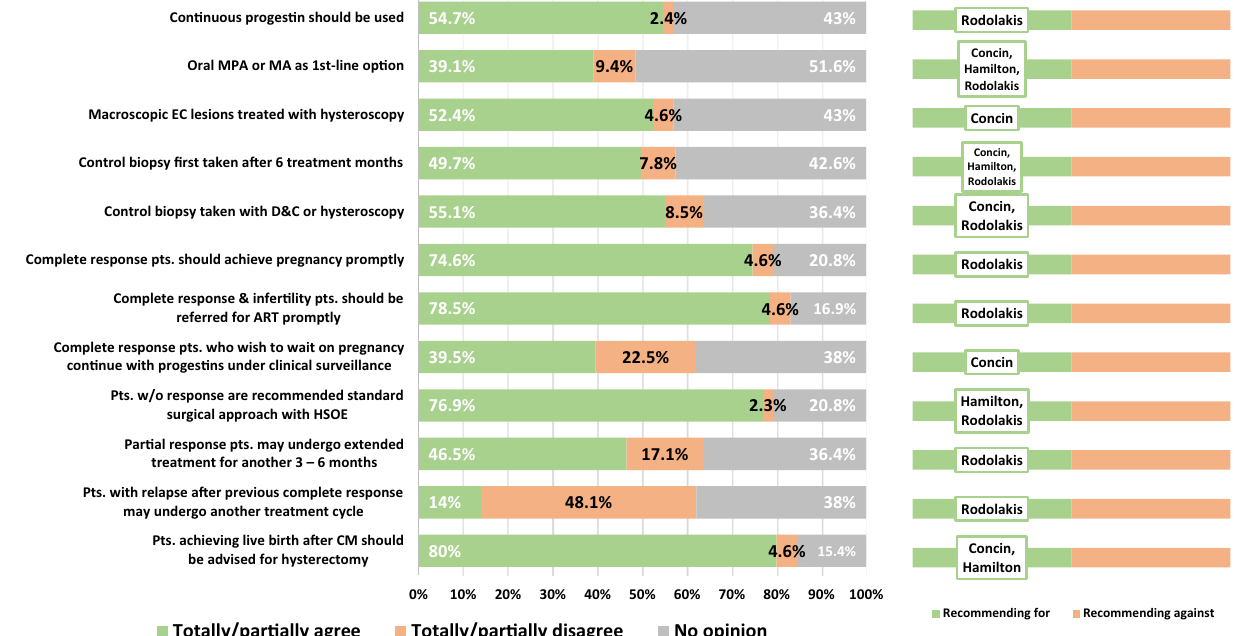
Figure 5. Oncology-specific treatment and follow-up criteria for conservative management of endometrial cancer in the study population as well as in relation to international recommendations and guidelines. MPA medroxyprogesterone acetate, MA megestrol acetate, EC endometrial cancer, D & C dilatation and curettage, ART assisted reproductive technology, Pts patients, w/o without, HSOE hysterectomy and salpingo-oophorectomy, CM conservative management. Question subset B was delivered to clinicians active in endometrial cancer care (N = 156). Response rate > 82% for all items. Citations with author names presented within the chart bars to the right refer to published guidelines recommending for/against individual treatment/follow-up criteria 6–8